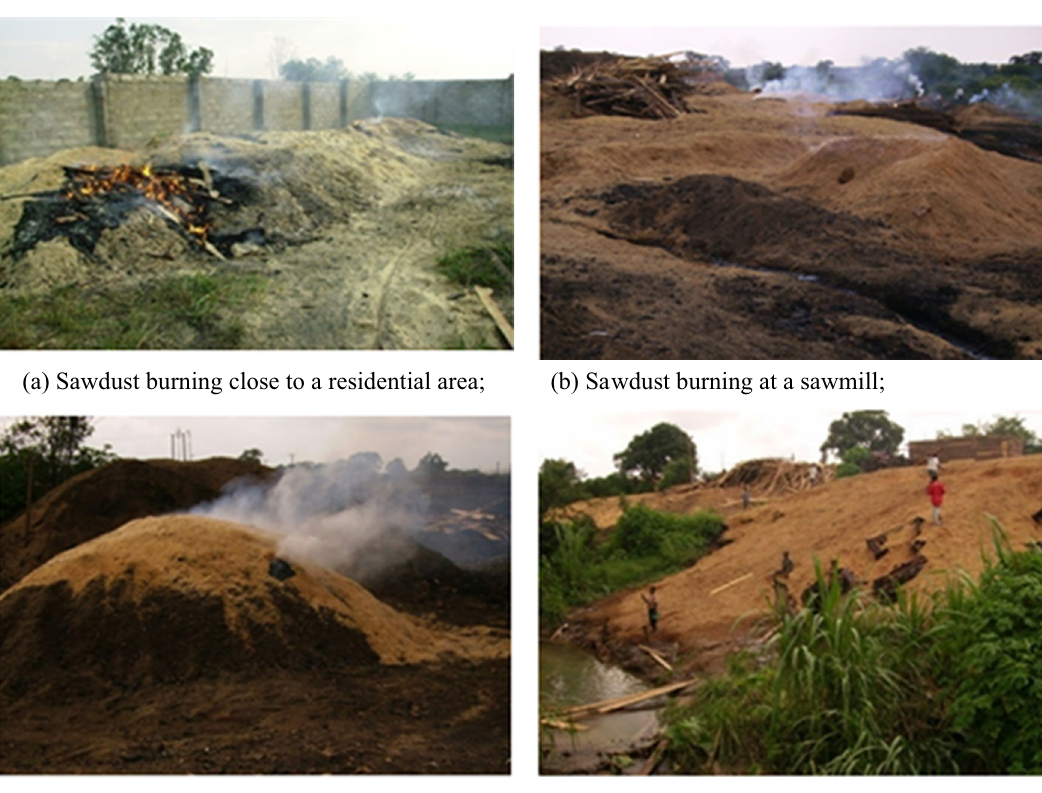
Fig. 1 Ditching of sawdust in the open